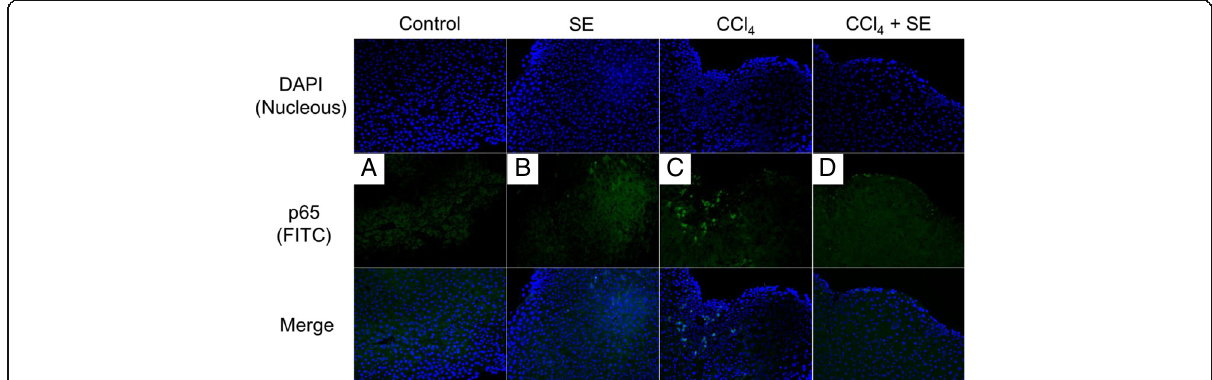
Fig. 7 Effect of treatment with SE on liver p65 fluorescent immunostaining. Animals treated as described in Fig. 2 were euthanized at 72 h post intraperitoneal injection, and the livers were harvested at necropsy. Liver specimens were removed, fixed, and processed by standard methods. Nuclei were counterstained with DAPI (blue). Expression and localization of p65 (green) were analyzed using rabbit anti-p65 monoclonal antibody and anti-mouse IgG-FITC. Panel in a - d indicate control, SE, CCl 4 , and CCl 4 + SE, respectively (Fig. 8). We confirmed p38, ERK, and JNK phosphoryl- ation following 8 weeks of CCl administration. Treat- 4